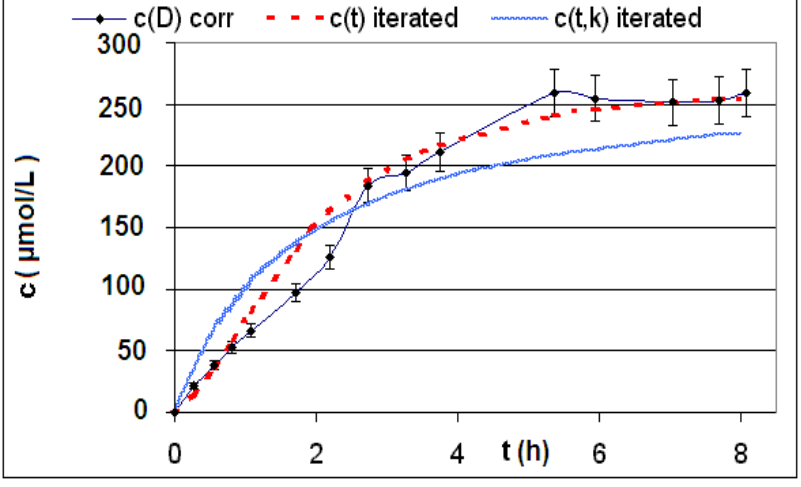
Figure 7. Reaction R6 comparison c